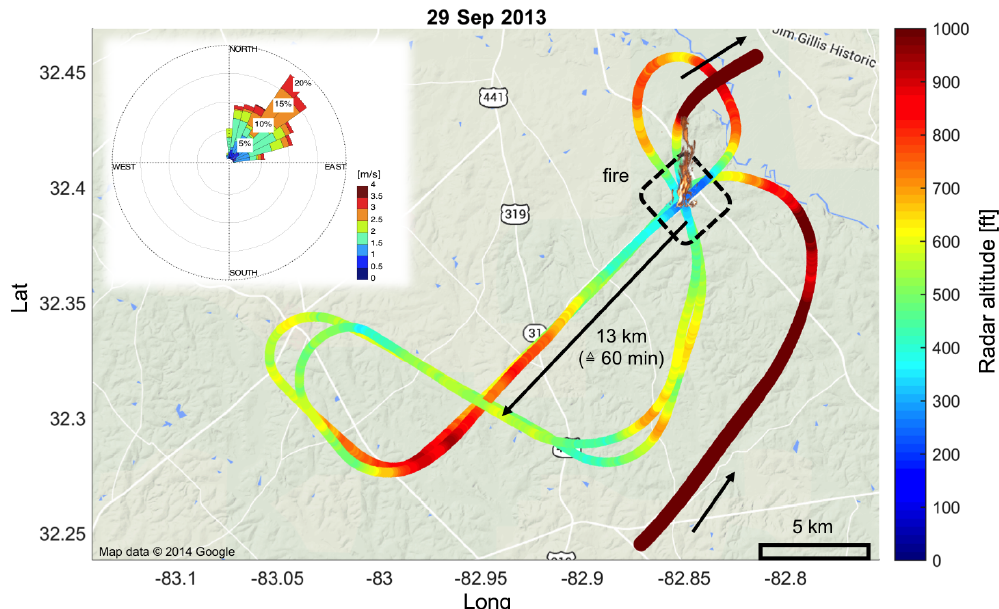
Figure 2. Flight pattern of the NASA P-3B to obtain four point source emission profiles, two longitudinal plume transects (source to 1h downwind), and two transverse downwind plume transects (1h downwind from source). The inset shows wind rose data obtained during the two longitudinal plume transects when wind measurements are most